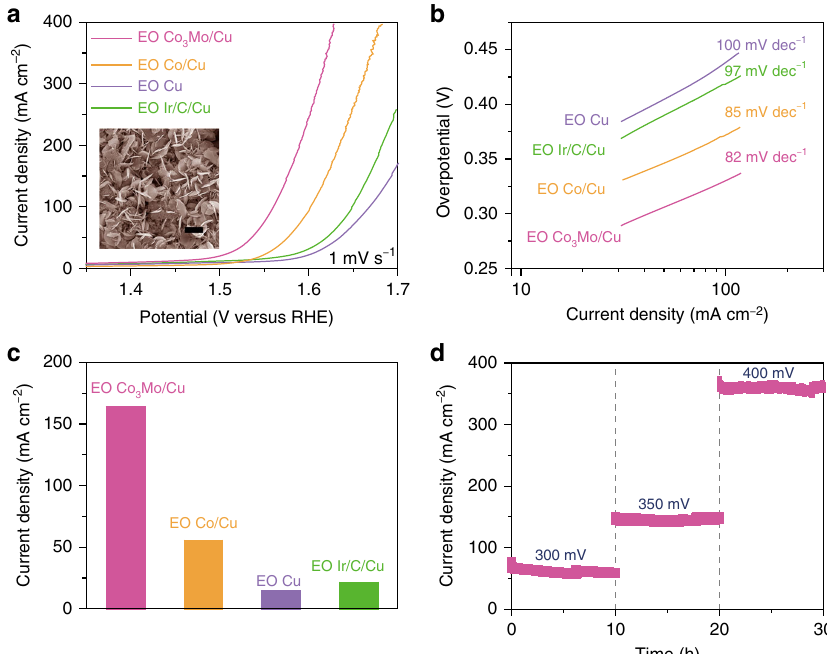
Fig. 4 Electrochemical characterization of OER properties. a iR-corrected OER polarization curves of the electro-oxidized nanoporous Co 3 Mo/Cu (EO Co 3 Mo/Cu), Co/Cu (EO Co/Cu), and bare Cu (EO Cu) in 1 M KOH electrolyte, along with commercially available Ir/C supported by nanoporous Cu (Ir/C/ Cu). Inset: typical SEM image of electro-oxidized nanoporous Co 3 Mo/Cu. Scale bar: 1 μ m. b Tafel plots comparing the Tafel slopes of different OER electrocatalysts according to the polarization curves in panel ( a ). c Comparison of current density of the EO Co 3 Mo/Cu electrode at the overpotential 350 mV with those of EO Co/Cu, EO Cu and nanoporous Ir/C/Cu. d Stability measurements of the electro-oxidized nanoporous Co 3 Mo/Cu at overpotential of 300, 350, and 400 mV for 30 procedure at a potential of 1.57 V vs. RHE (Supplementary